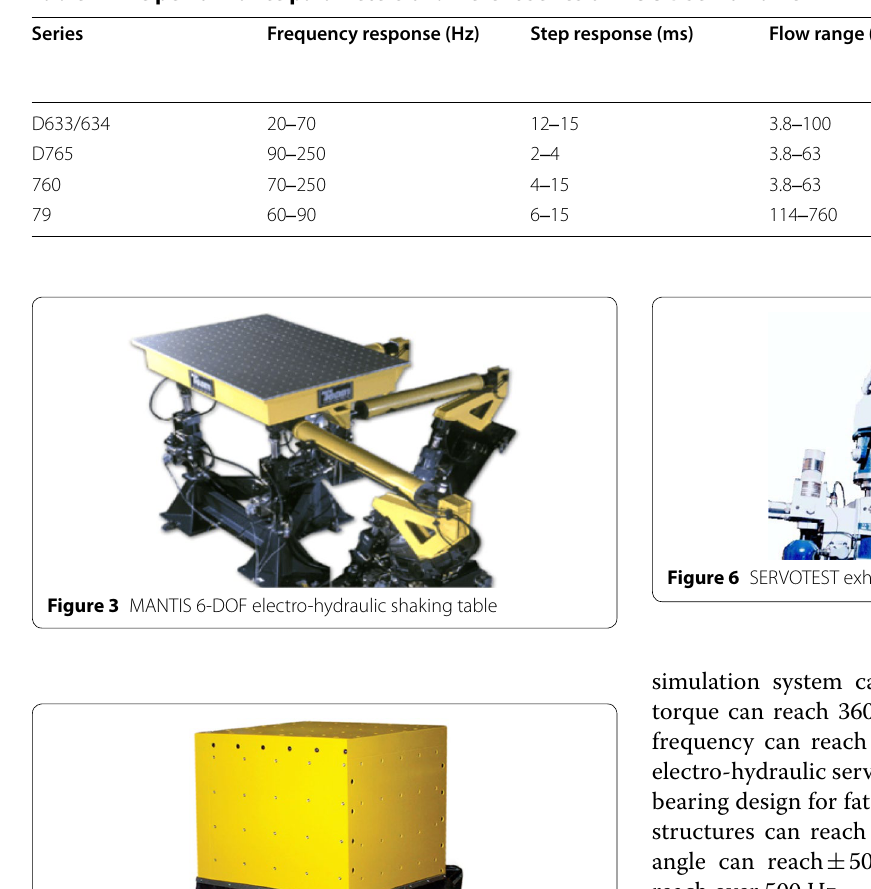
Table 1 The performance parameters of different series of MOOG servo‑valve